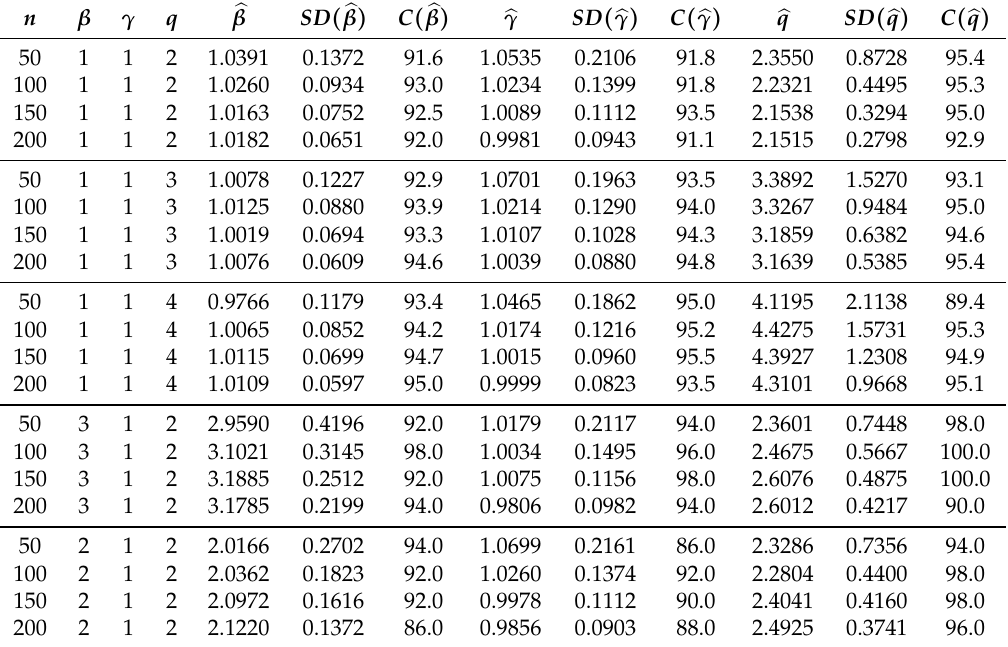
Table 2. Simulation of 1000 iterations for the SPM ( β , γ , q ) model.